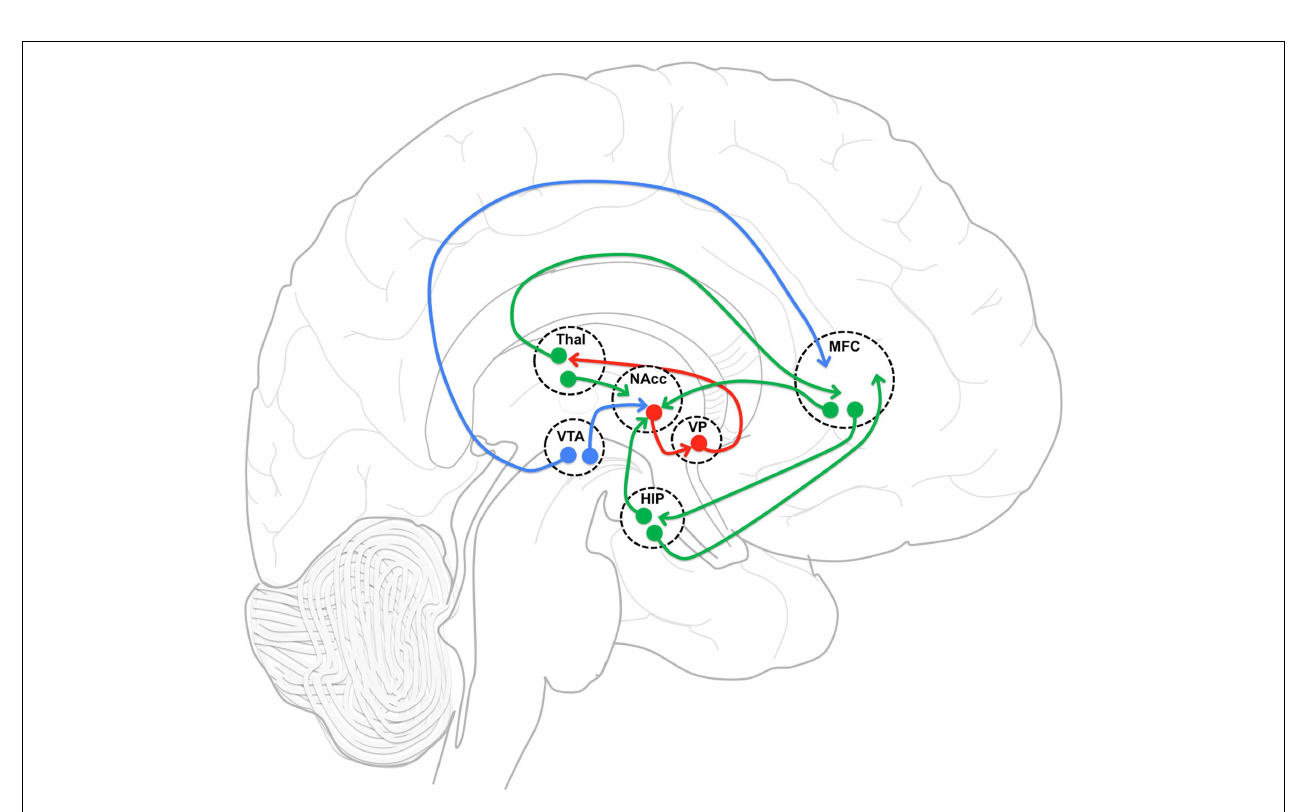
(blue) projections with an emphasis on MFC and HIP projection interactions in nucleus accumbens (NAcc).VP, ventral pallidum;Thal, thalamus;VTA, ventral tegmental area.